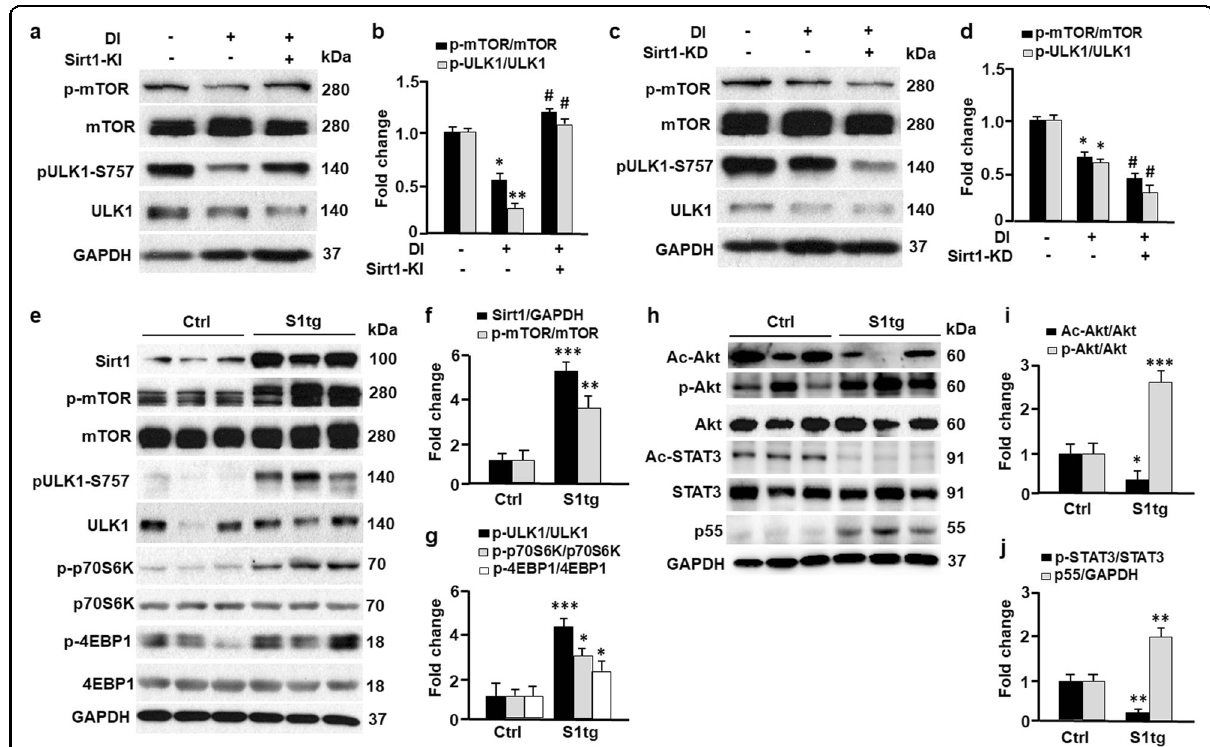
Fig. 4 Sirt1 suppressed autophagy by activating AKT-mTOR and STAT3-p55 pathways. a , b The effects of Sirt1 knock-in (Sirt1-KI) on the mTOR- ULK1 cascade were measured by Western blotting ( a ) and densitometric analyses ( b ). Control and Sirt1-KI 3T3L1 cells were treated with differentiation inducer (DI), and the cells were harvested on day 12 for Western blotting analysis. GAPDH was probed as a loading control. Comparing DI( − )Sirt1-KI( − ) with DI( + )Sirt1-KI( − ): * p < 0.05; ** p < 0.01. Comparing DI( + )Sirt1-KI( − ) with DI( + )Sirt1-KI( + ): # p < 0.05. n = 8. c , d The effects of Sirt1 knock-down (Sirt1-KD) on the mTOR-ULK1 cascade were determined by Western blotting ( c ) and densitometric analyses ( d ). Control and Sirt1-KD 3T3L1 cells were treated with differentiation inducer (DI), and cells were harvested on day 9 for Western blotting analysis. Comparing DI( − )Sirt1-KD ( − ) with DI( + )Sirt1-KD( − ): * p < 0.05. Comparing DI( + )Sirt1-KD( − ) with DI( + )Sirt1-KD( + ): # p < 0.05. n = 8. e – g The effects of Sirt1 on mTOR and downstream targets (ULK1, p70S6K, and 4EBP1) in inguinal adipose tissues were determined by Western blotting ( e ) and densitometric analyses ( f , g ). S1tg, Sirt1 transgenic mice; Ctrl, control mice. Comparing Ctrl with S1tg mice: * p < 0.05; ** p < 0.01; *** p < 0.001. n = 6. h – j The effects of Sirt1 on protein kinase B (AKT) and signal transducer and activator of transcription 3 (STAT3) in inguinal adipose tissues were determined by Western blotting ( h ) and densitometric analyses ( i – j ). Ac-Akt, acetylated Akt; Ac-STAT3, acetylated STAT3. Comparing Ctrl with S1tg mice: * p < 0.05; ** p < 0.01; *** p < 0.001. n =